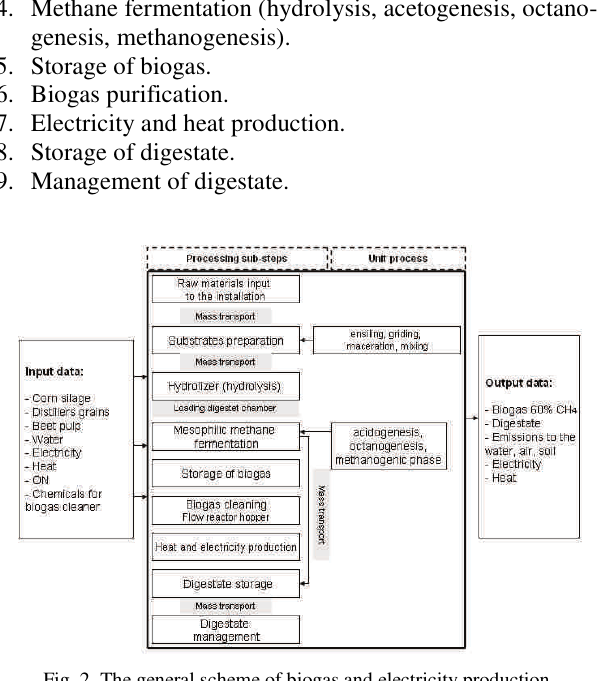
Fig. 2. The general scheme of biogas and electricity production For technology stage in the scope of analysis was in- clude also transport of slop grains from Krasnystaw distill- ery at the distance of 98 km (both 196 km in total) and sugar beet pulp from the sugar factory in Suchowola at a distance of 19.2 km (38.4